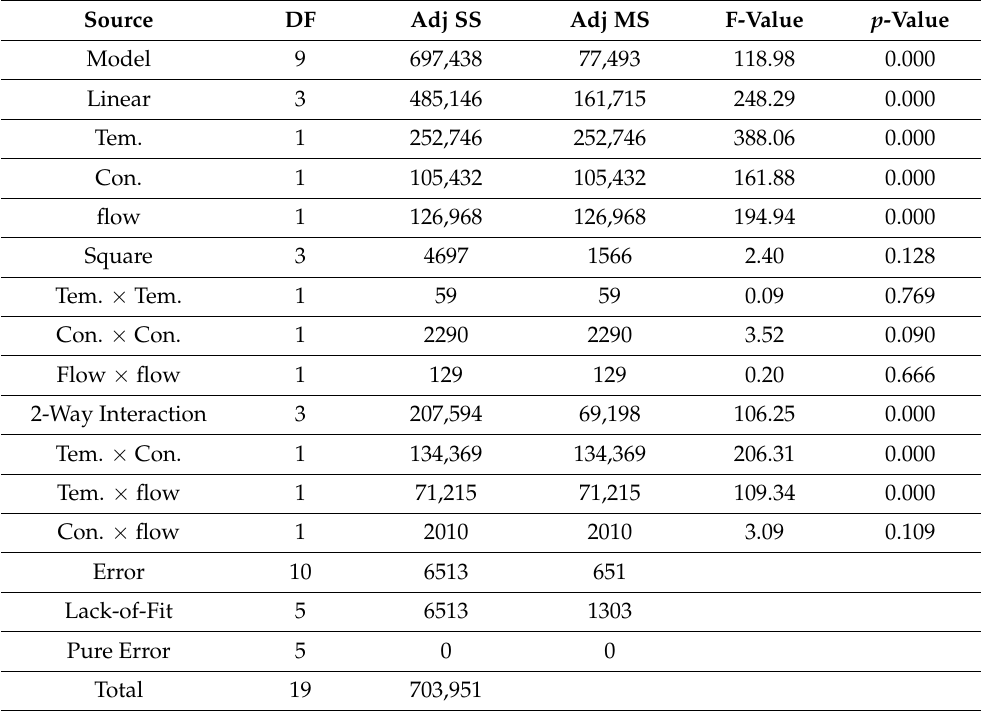
Table 4. Analysis of variance for separation